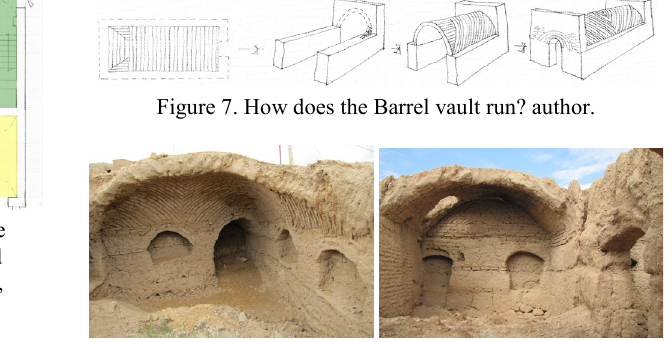
Figure 8. From left; Combination of Chahar-dori vault and Barrel vault, espar wall and Barrel vault, author.